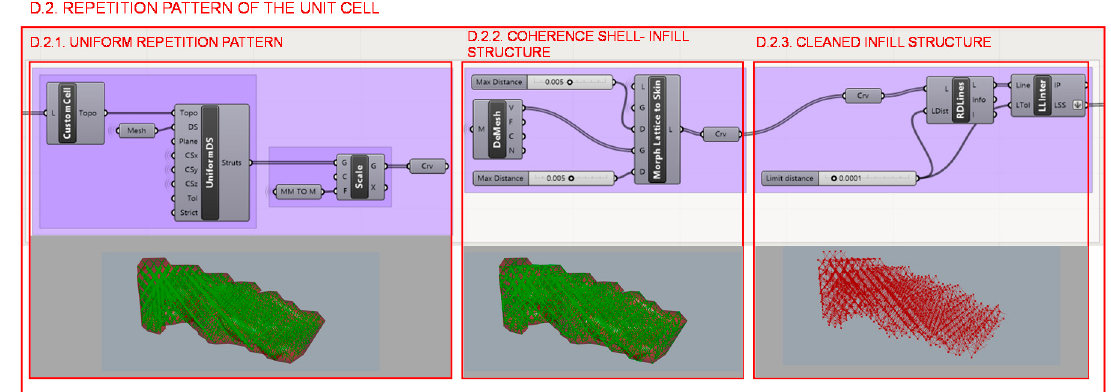
Figure 26. Programming structure definition of the infill pattern repetition and its visualization in the Rhinoceros interface.